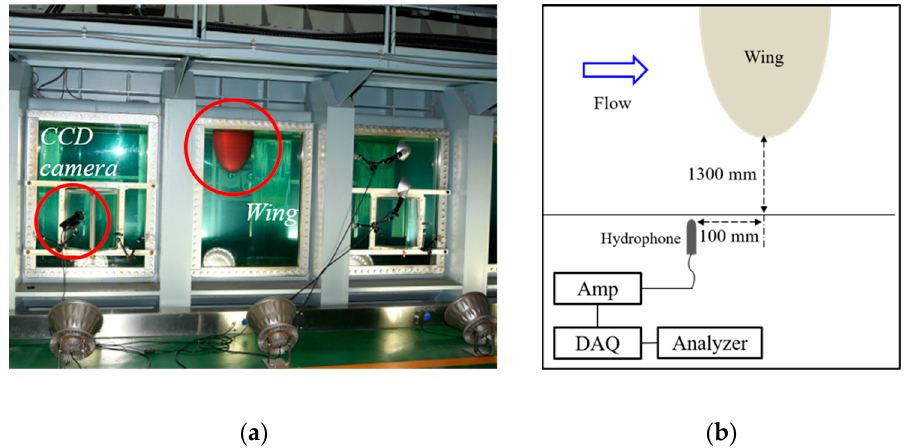
Figure 9. Experimental setup; ( a ) for visualization; ( b ) for noise measurement .